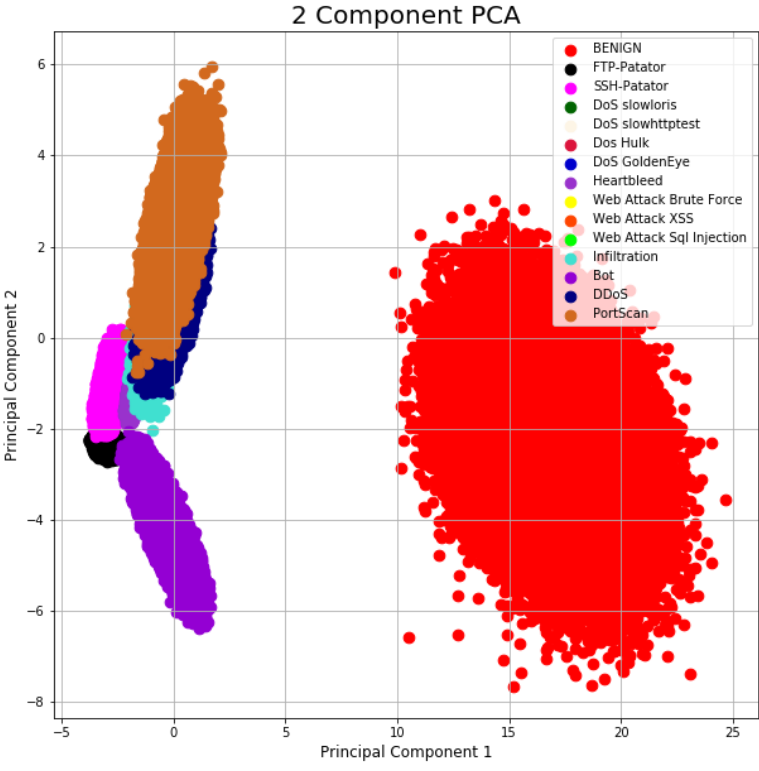
Figure 8. 2D Visualization of PCA on CICIDS2017 with